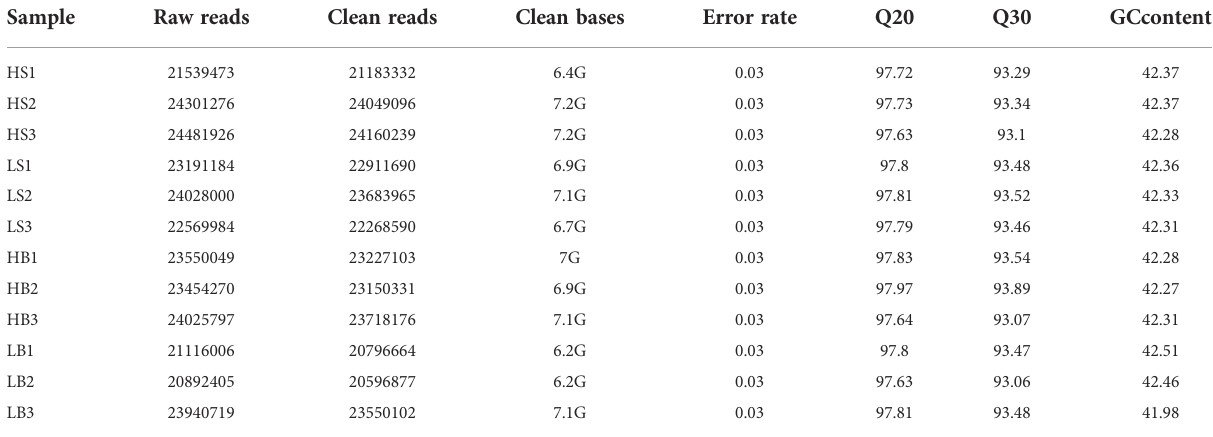
TABLE 2 Transcriptome sequencing data of all samples.